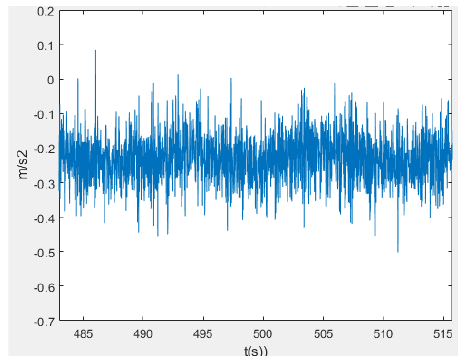
Fig. 8. Non processed results from angular velocity measurement.